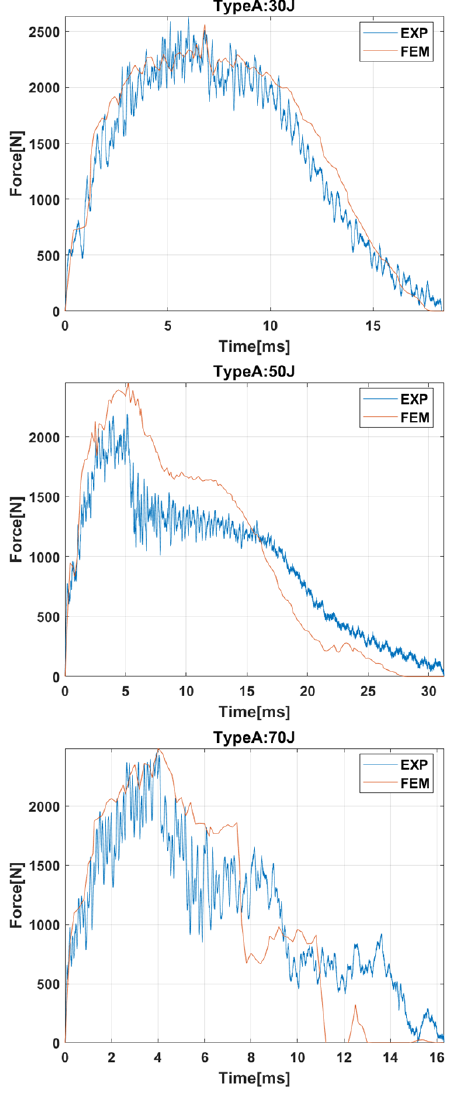
Figure 6. Force history of bumper beam type A under impact energies of 30 J, 50 J, and 70 J.